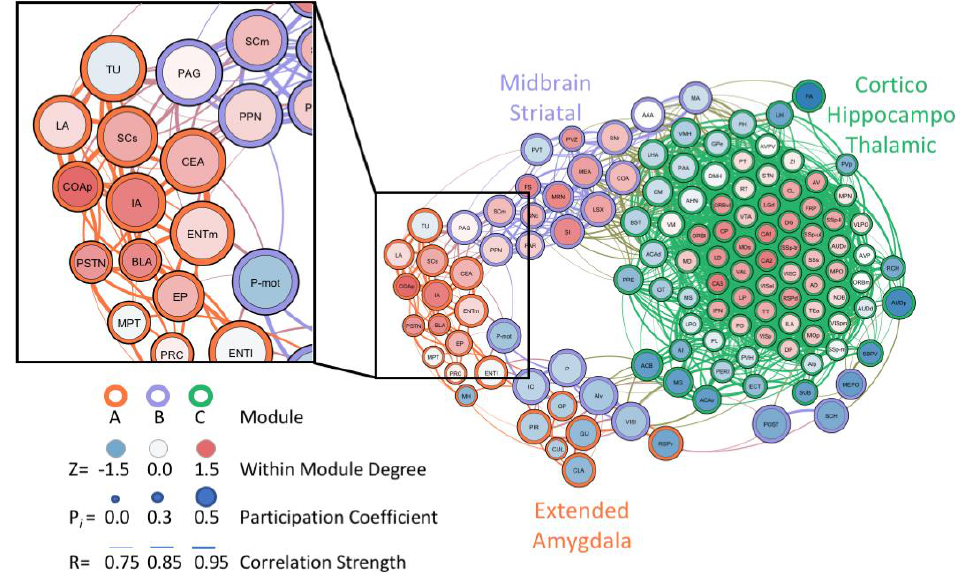
Figure 2. Graph theory representation of the neural network associated with alcohol abstinence in alcohol-dependent mice. Analysis identified several underexplored regions within the extended amygdala module that may be critical for withdrawal-associated behavior and excessive alcohol drinking. The zoomed-in panel highlights several of the underexplored regions, which include the posterior cortical amygdala (COAp), intercalated amygdala (IA), parasubthalamic nucleus (PSTN), and tuberal nucleus (TU). Figure reproduced and modified from Kimbrough et al., 2020 PNAS .